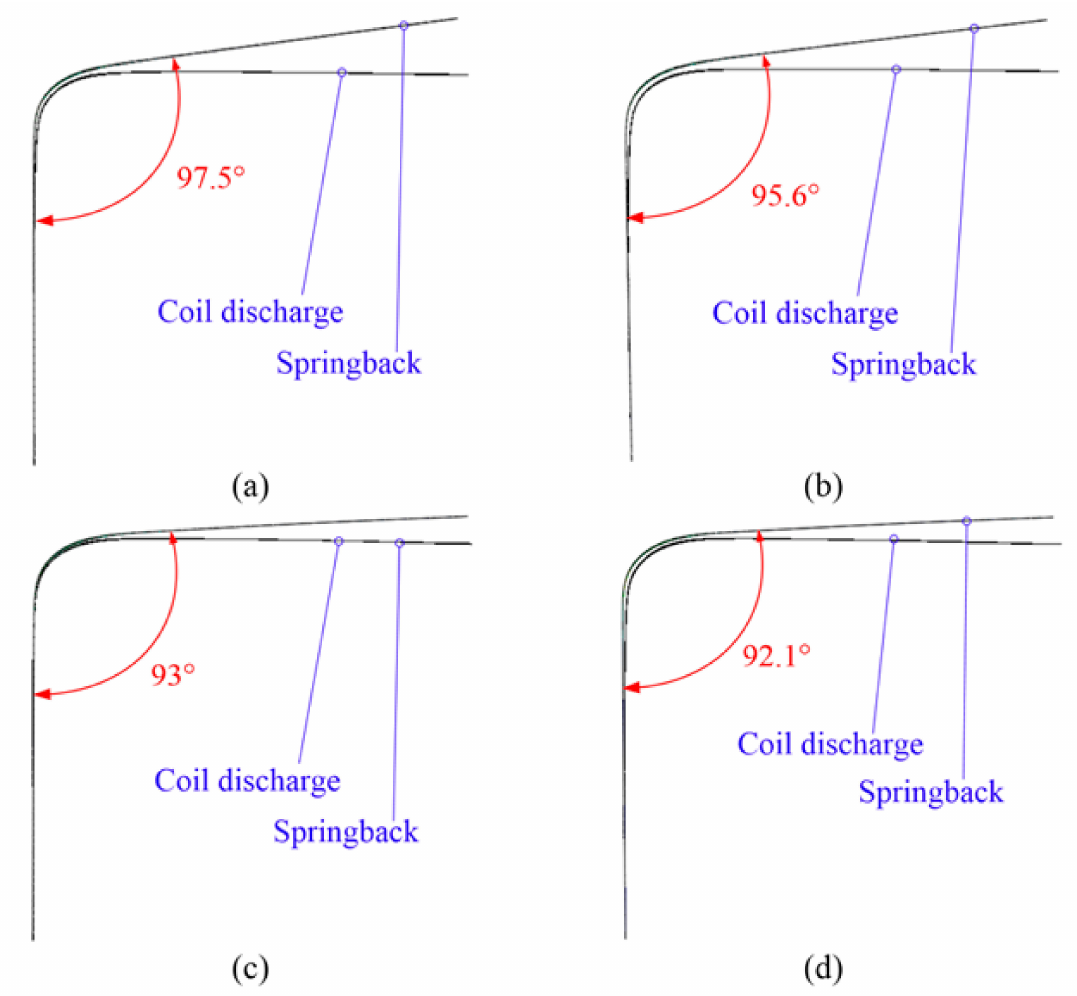
Figure 18. Springback angle from the front view after a coil discharge of ( a ) 5 kV, ( b ) 6 kV, ( c ) 7 kV, and ( d ) 7.5